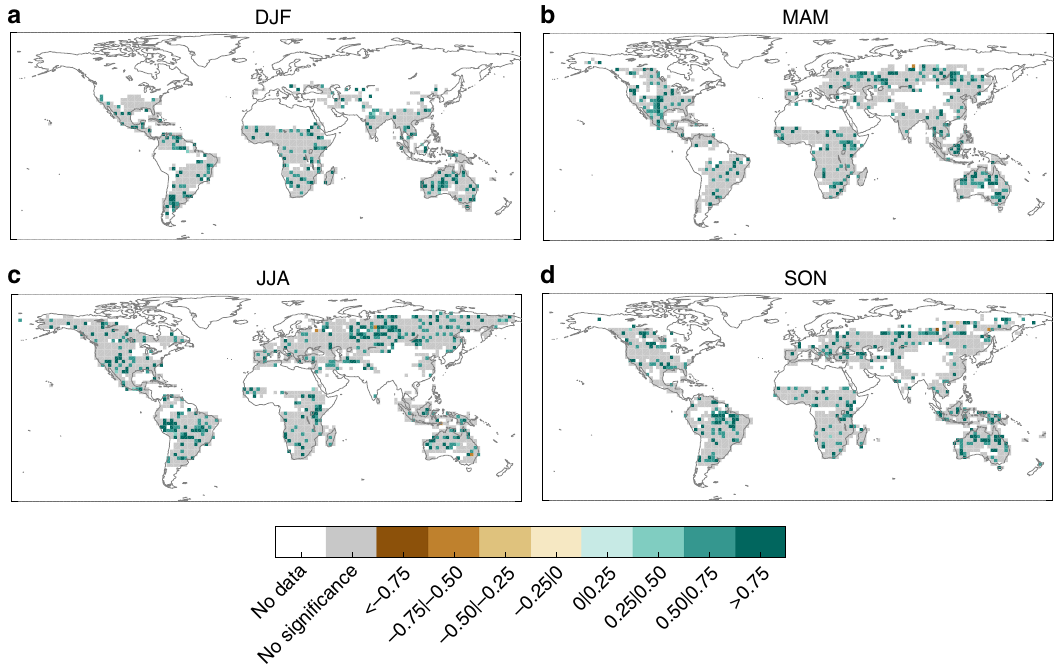
Fig. 7 Comparison with predictions based on a null model. Differences in correlations of out-of-sample burned area (BA) predictions using seasonal forecasts of SPI based on the BESTENS ensemble and those based climatology, that is, considering only long-term averages of observed BA for a differences are shown. Grey colour shadows the grid points with non-signi fi cant differences. White indicates areas where fi res do not occur (e.g. sea) or have not been